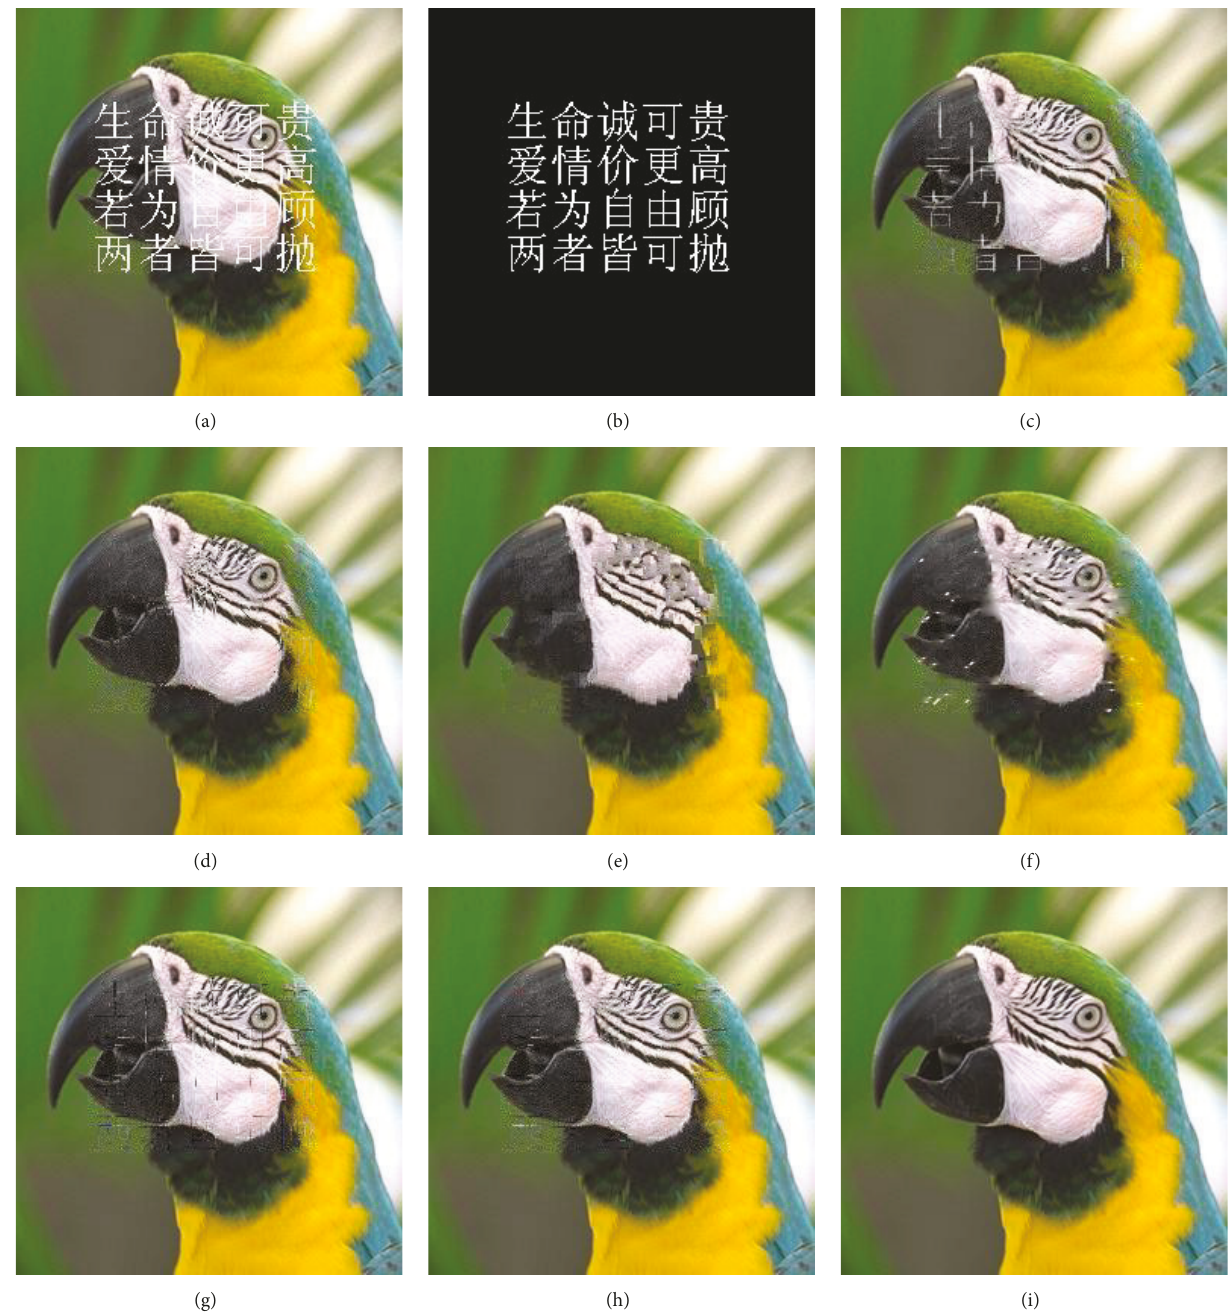
Figure 10: Repaired parrot images by different inpainting methods. (a) The damaged image; (b) the mask image; (c) by BSCB; (d) by CT; (e) by EB; (f) by TV; (g) by Thiele; (h) by our method; (i) the original